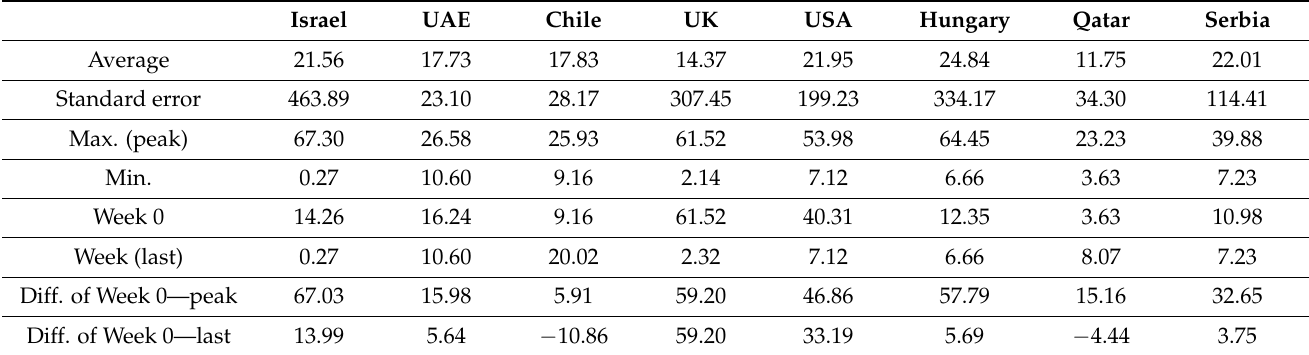
Table 2. Infection rates during the analysis period (unit: cases per 10,000